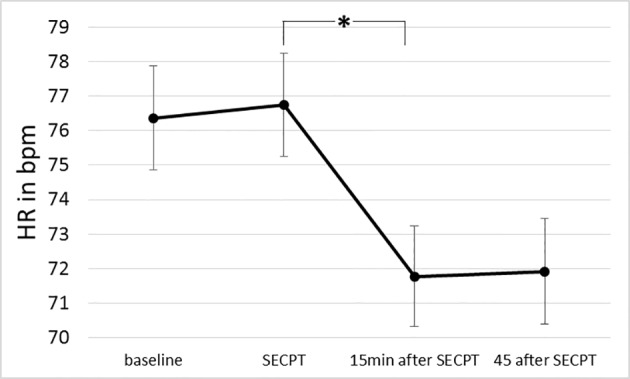
Changes in HR over time (before, during, and after the stress). Error bars indicate one standard error. SECPT, socially evaluative cold pressor test. *indicate significant differences between time points.